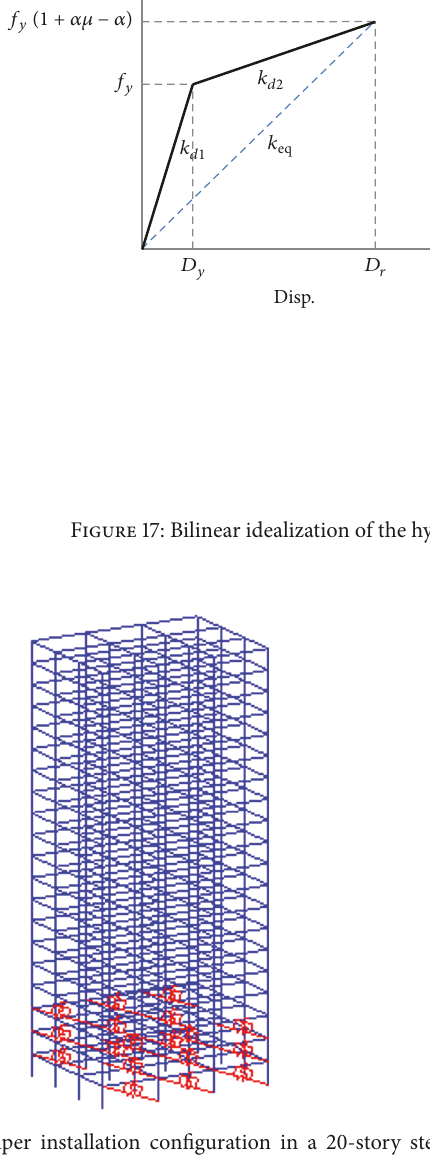
Figure 19: Added damping ratio and wind load reduction